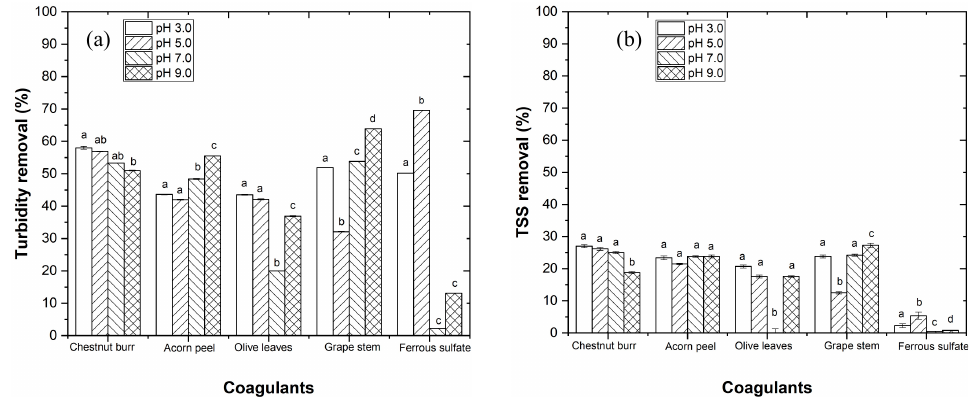
Figure 5. Progress of ( a ) turbidity and ( b ) TSS removal, testing different pH values (3–9). Experimental conditions: 1.0 g L − 1 for each coagulant, T = 25 °C, fast mix 150 rpm for 3 min, slow mix 20 rpm for 20 min, sedimentation time of 12 h ([TOC] 0 = 144 mg C L − 1 , turbidity 0 = 16 NTU, TSS 0 = 64 mg L − 1 ). Different letters between the graphic bars mean that values are statistically different ( p < 0.05). When bars have two letters (ab), it means the values are not statistically different from a and from b.